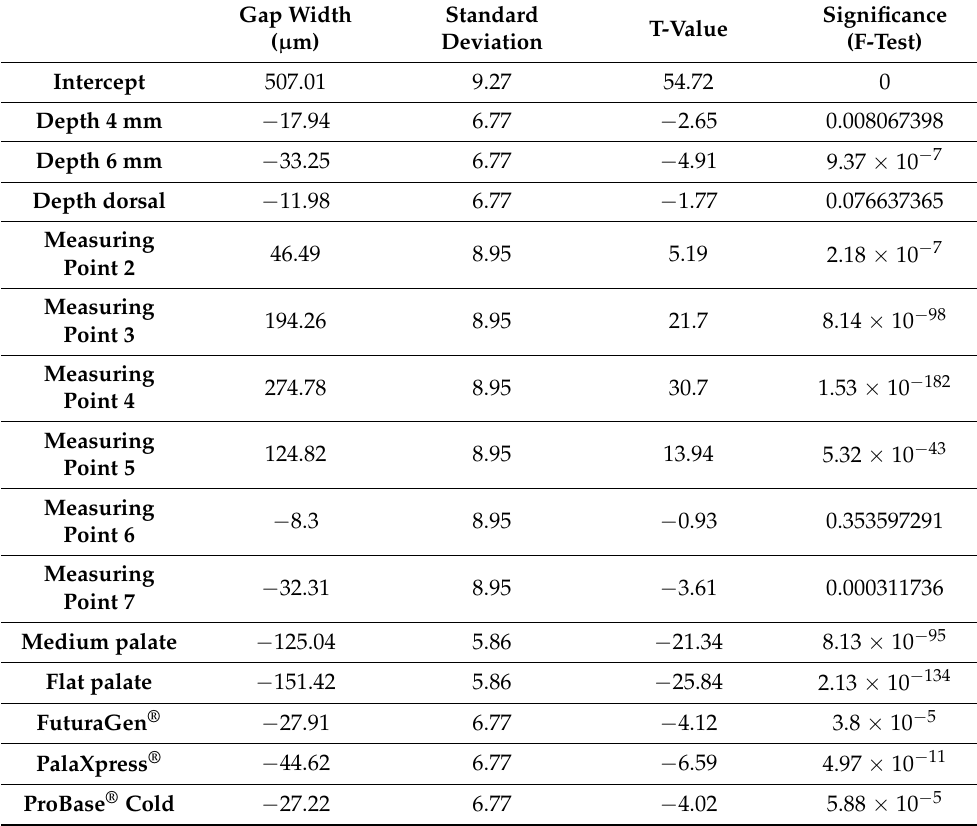
Table 1. Gap width according to the multiple linear regression.